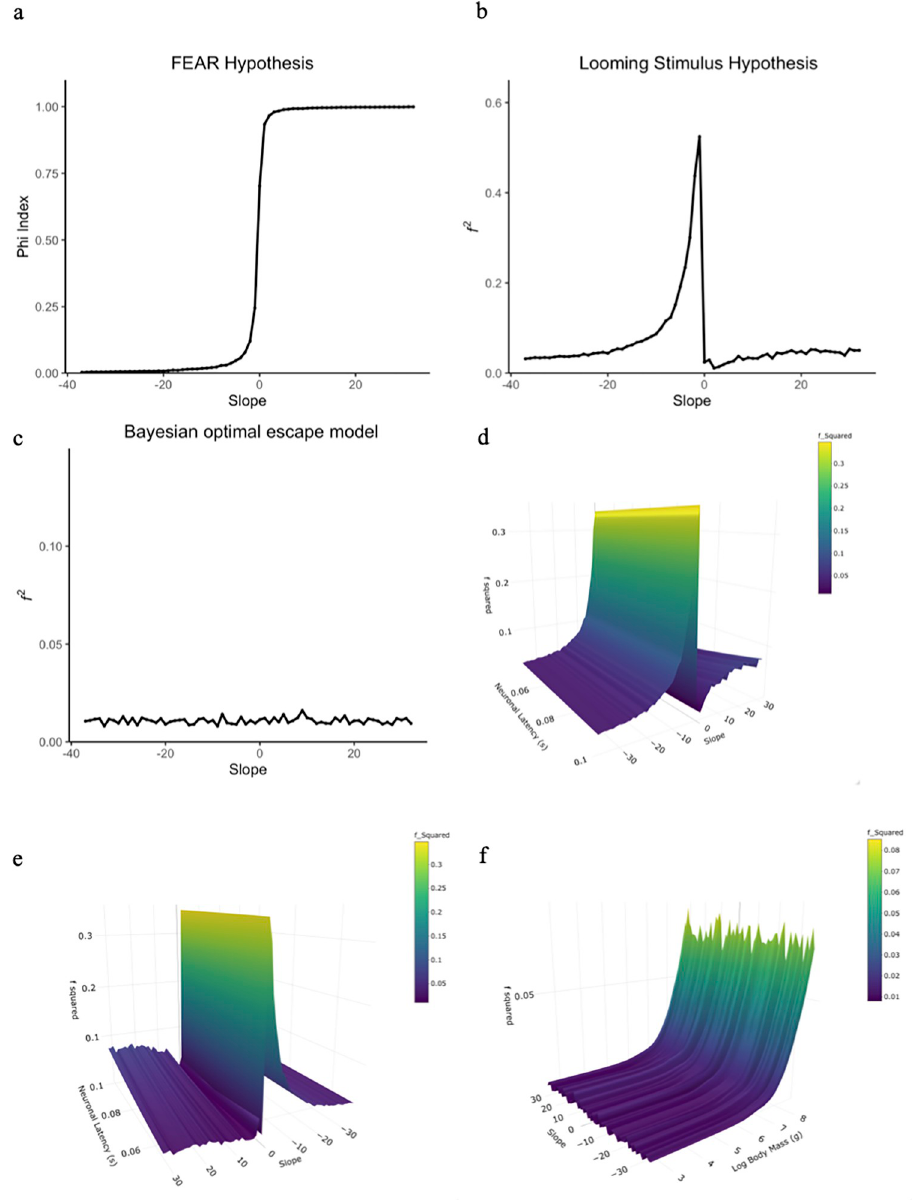
Fig 4. Changes in approach speed’s effect size (i.e., the phi-index, or f 2 ) with different slopes for the FID and approach speed relationship for three different models potentially sensitive to vehicle approach speed. a) The mean phi-index, the effect size metric for the FEAR hypothesis, across iterations for each slope. The figure suggest that model is most sensitive to vehicle approach speed when the slope is equal to or greater than zero. b) The mean f 2 across iterations for each slope according to the looming hypothesis when latency is 0.075 seconds, which suggest the model is sensitive to the delayed margin of safety. c) The mean f 2 across iterations for each slope according to the Bayesian optimal escape model when the body mass is 267.4 grams, which suggest the model is not sensitive to approach sped. d & e) The mean f 2 across iterations for each combination of slope and neuronal latency value for the looming stimulus hypothesis. d and e show the same graph but from two different viewpoints. Across neuronal latency values it seems the model is sensitive to the speed effect at slightly negative slopes. f) The mean f 2 across iterations for each combination of slope and body mass value for the Bayesian optimal escape model. The figure suggests that only at a size of larger then 1kg is the model FID predictions sensitive to vehicle approach speed.